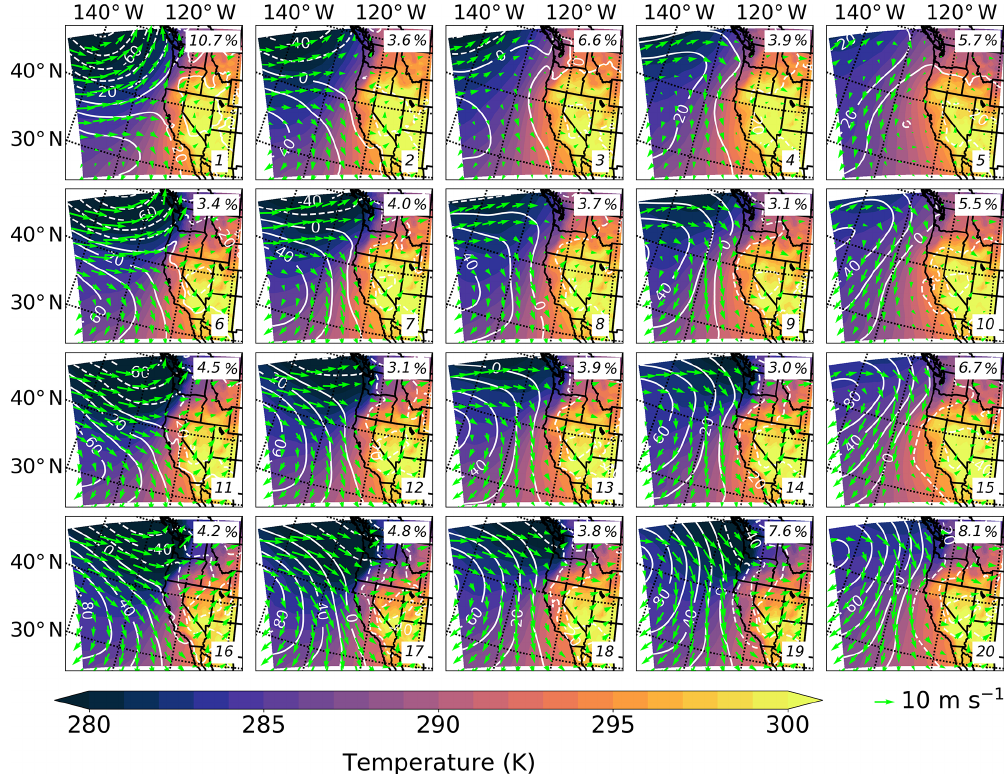
Figure 3. Synoptic-scale 850hPa spatial anomaly height field (white lines contoured every 20m), in addition to temporal mean temperatures (contoured every 1K according to color bar) and wind vectors (lime green arrows with 10ms − 1 reference vector) as represented by the 4 × 5 SOM node topology. Each panel represents a node (number displayed in the bottom right corner), while the percentage frequency of occurrence is displayed in the top right